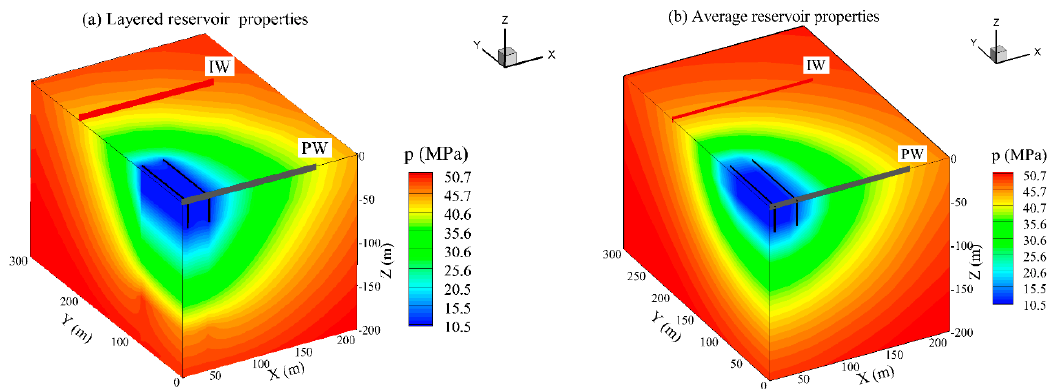
Figure 8. A comparison of reservoir pore pressure distribution ( a ) the FEM model (with layered reservoir properties) and ( b ) the DD model (with average reservoir properties) after 2 years of production. There is close agreement between the two models.